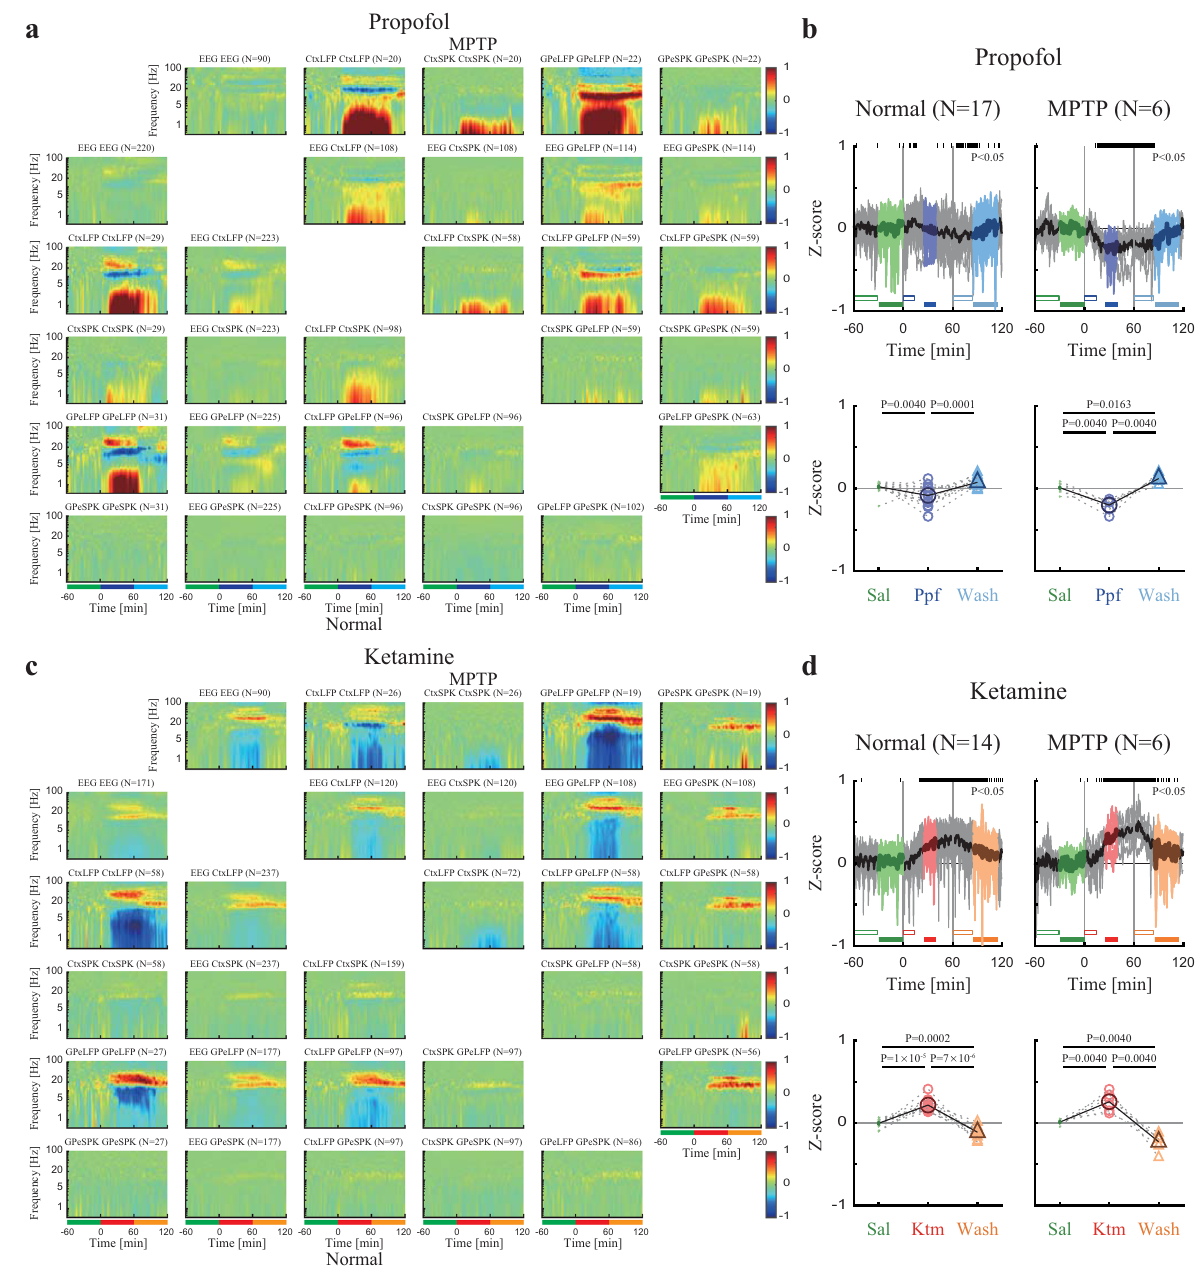
Fig. 3 Propofol and ketamine increase and decrease low-frequency synchronization, respectively, in cortico-basal ganglia neuronal activity. a The normalized magnitude-squared coherograms of all pairs of EEG, Ctx LFP/SPK, and GPe LFP/SPK during saline baseline, propofol sedation, saline washout before (lower left) and after MPTP-treatment (upper right). The 1 st row/column shows coherograms within the same signal type (e.g., EEG to EEG), other subplots show coherograms between different signal types. The lower bar represents 1-hour time periods of saline baseline (green), propofol sedation (blue), and saline washout (cyan). b Upper. The normalized high/low synchronization difference (averaged through all coherograms within one session) between high-frequency (12 – 40 Hz) and low-frequency (0.5 – 4 Hz) coherence domains before (left) and after (right) MPTP-treatment. Top black horizontal bar represents a signi fi cant difference compared to saline ( p < 0.05, Kruskal – Wallis test). Lower. The change from saline baseline of the normalized high/low synchronization difference during saline (upper, green minus empty green), propofol sedation (upper, blue minus empty blue), saline washout (upper, cyan minus empty cyan) before (left), and after MPTP-treatment (right). P -value is given, Kruskal – Wallis test. c , d Same conventions as a, b. during ketamine. Color represents saline baseline (green), ketamine sedation (red), and saline washout (orange). The number of pairs ( a , c ) and sessions ( b , d ) is given for both monkeys for each subplot. Abbreviations as in Fig.